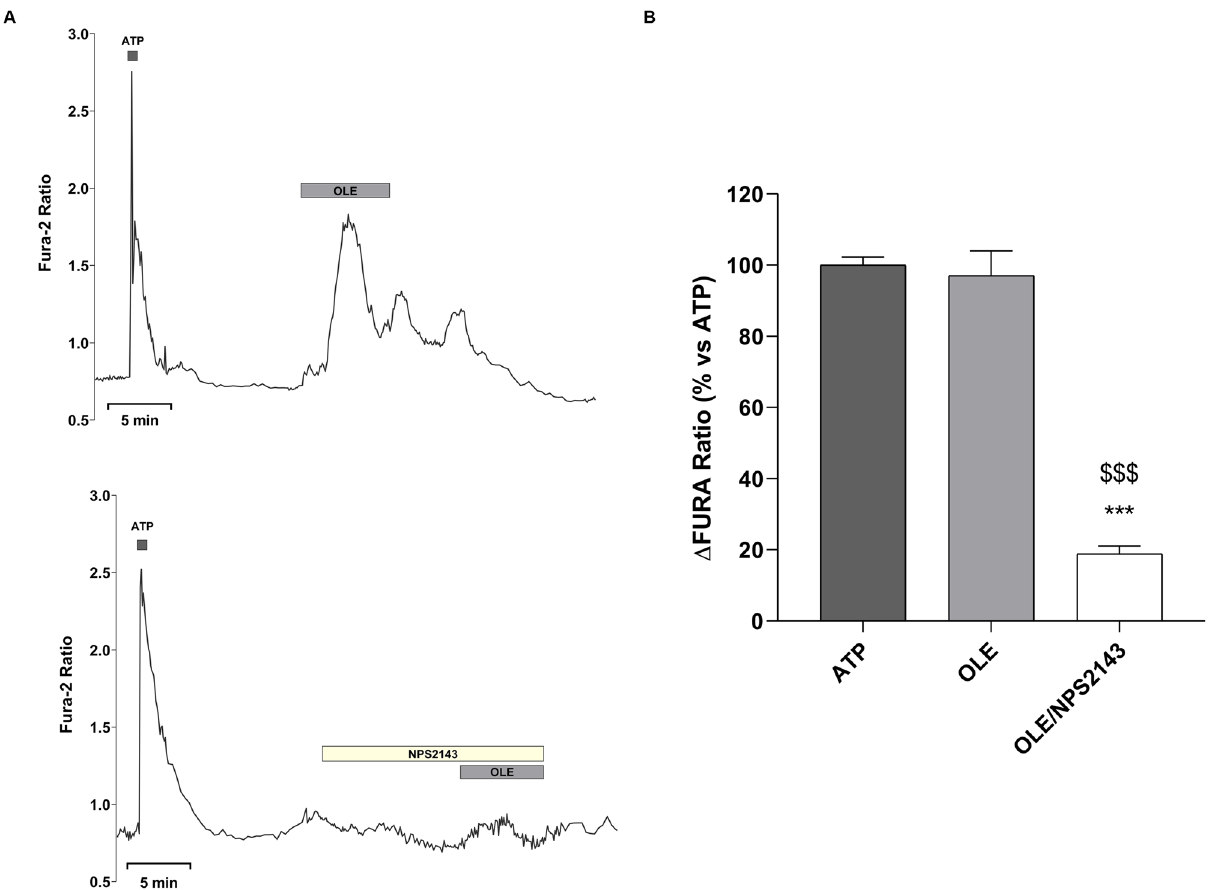
Figure 4. Effects of OLE on intracellular calcium oscillations in MCD4 cells. ( A ) MCD4 cells, loaded with Fura-2AM (4 μM for 15 min) as described in methods, were stimulated with OLE (1 mg/ml) in the absence or in the presence of NPS2143 (10 µM). Fluorescence ratio 340/380 nm was recorded and responses to OLE or OLE/NPS2143 were compared to that obtained after stimulation with a maximal dose of the calcium-mediated agonist ATP (100 μM) that was used as an internal control (100%). Each trace is representative of 3 different experiments with similar results. ( B ) Histogram shows the ΔFura Ratio percentage. Data are expressed as means ± S.E.M experiments (***p < 0.001 vs ATP; $$$p < 0.001 vs